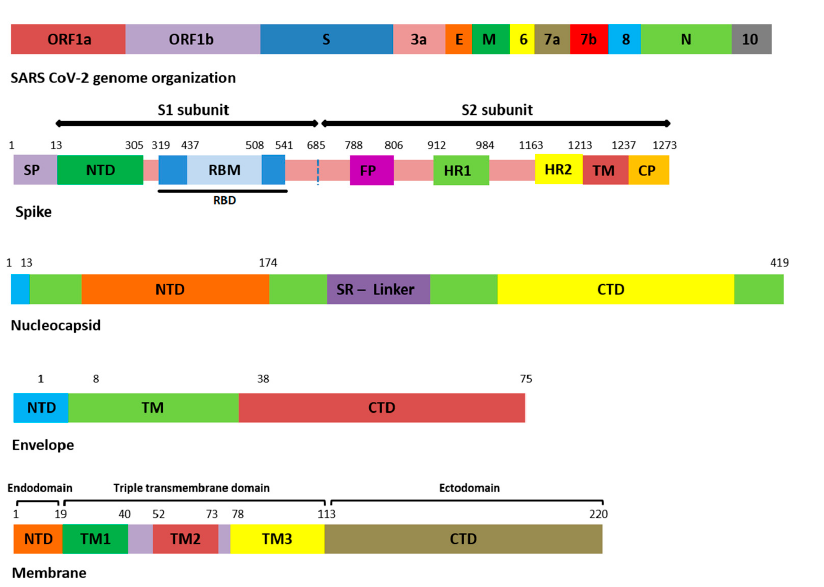
Figure 1. Domain organization of structural proteins. ORF: open reading frame, E: envelope, M: membrane, N: nucleocapsid, SP: signal peptide, NTD: N-terminal domain, RBD: receptor-binding domain, RBM: receptor-binding motif, FP: fusion peptide, HR: heptapeptide repeat sequence, TM: transmembrane, CP: cytoplasmic domain, SR: serine rich, CTD: C-terminal domain.